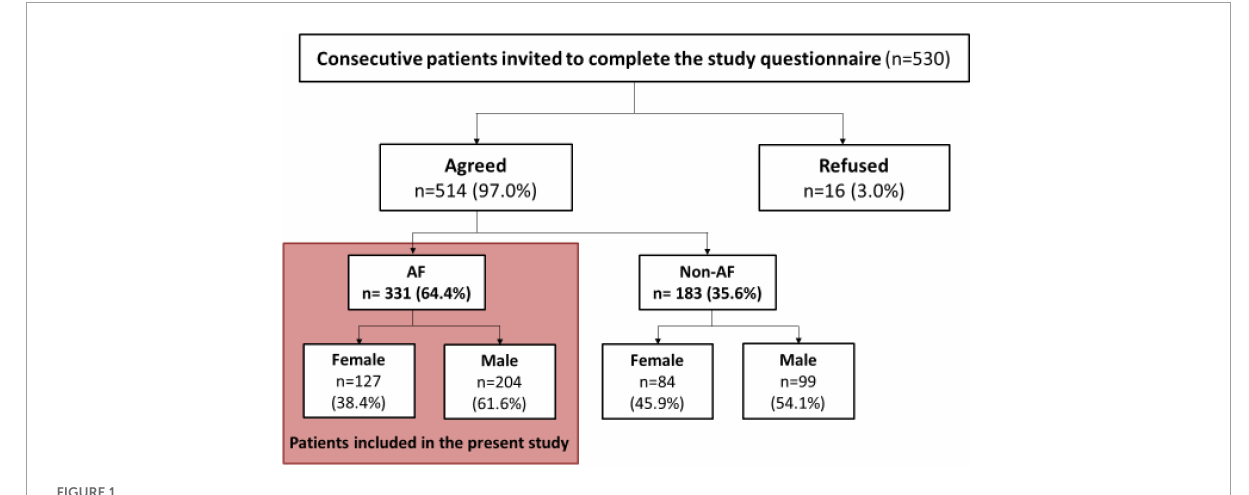
FIGURE1 Study flowchart. AF, atrial